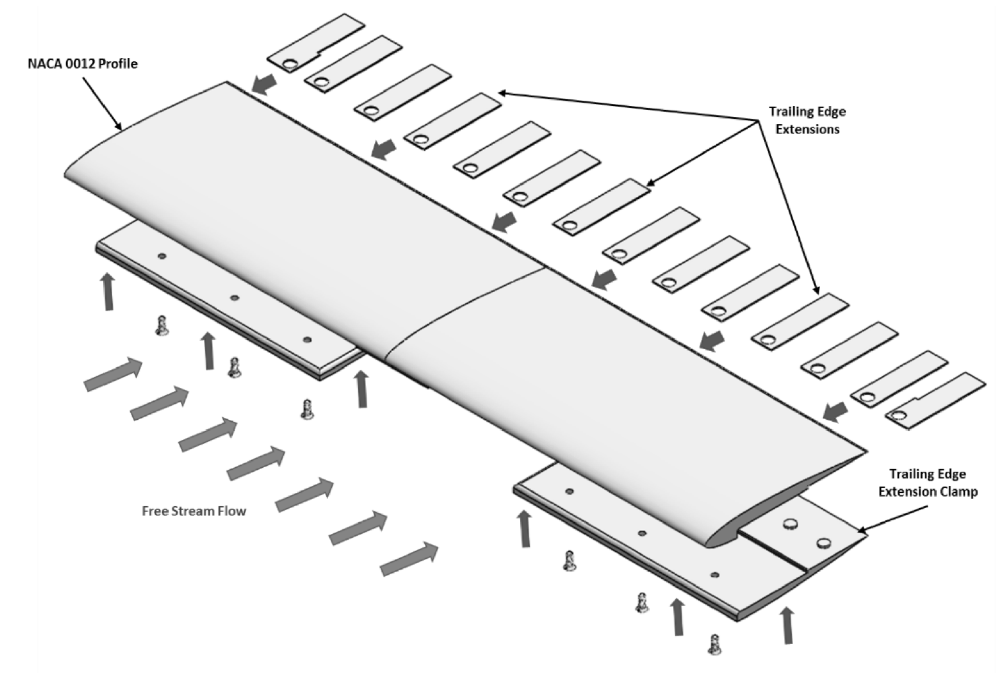
Figure 5. SolidWorks model of the AR 4 NACA 0012 wing with trailing edge (TE) extensions.